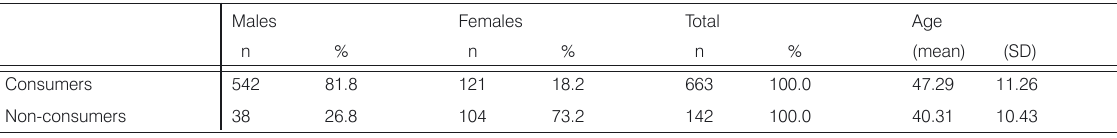
n-number; SD-Standard